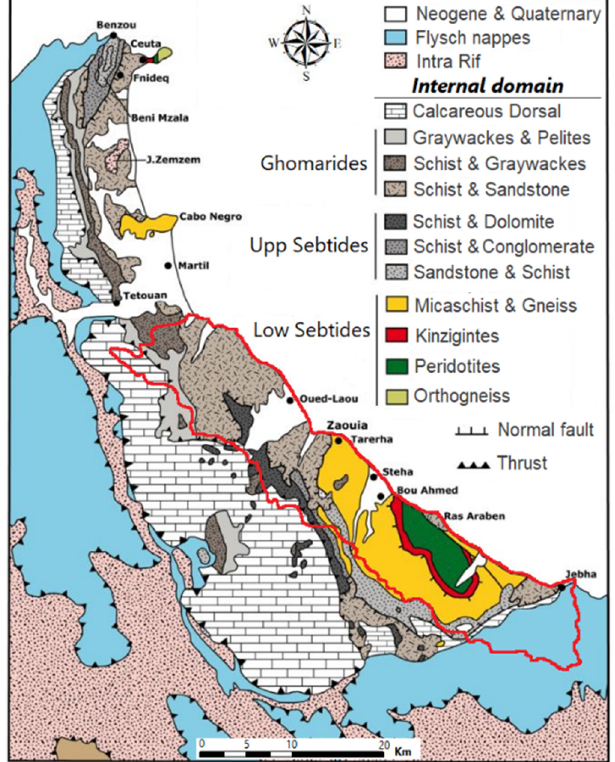
Figure 2. Geological map of the northwestern Rif [18] (modified). The area is surrounded in red.